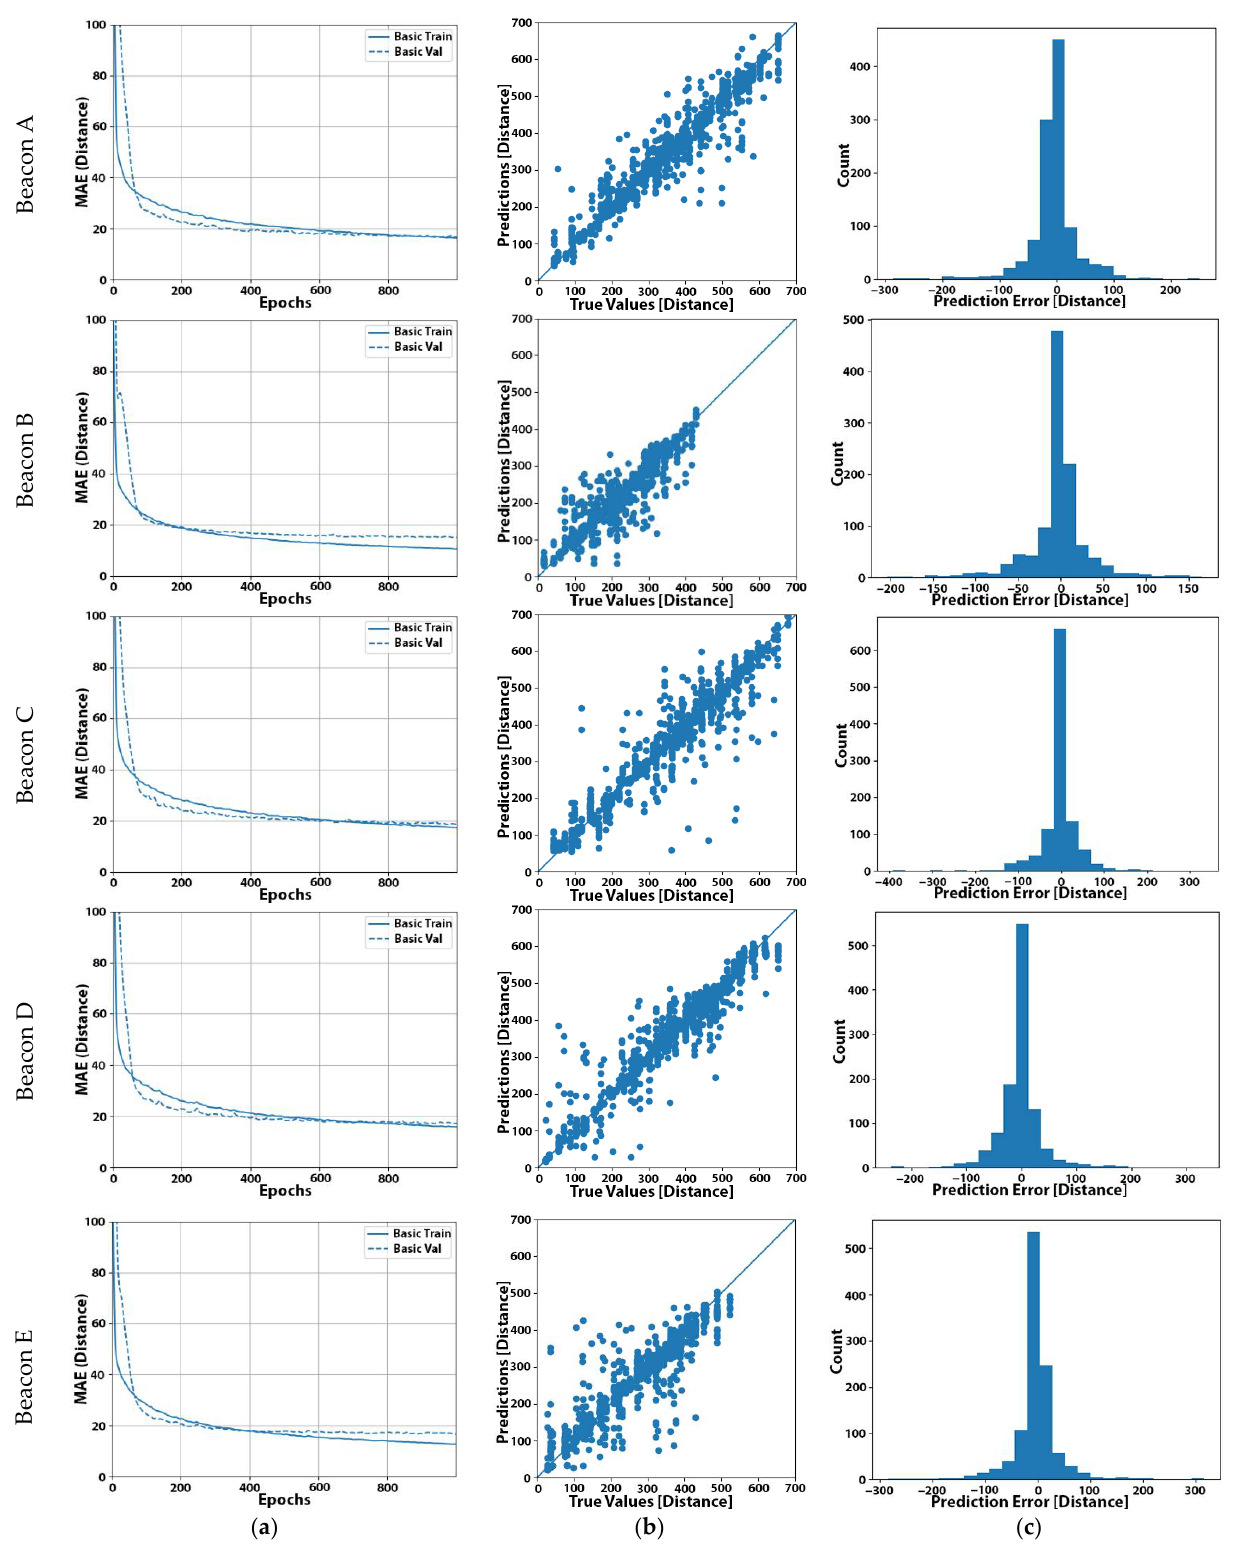
Figure 4. Experiment No. 23 results: ( a ) learning curve with the MAE of our final model; ( b ) plot of the predicted distance (in cm) from our final model against the actual distance of the user for the set of 1111 measurements; ( c ) distribution of the prediction error (in cm) using our final model. (Distances are expressed in cm in ( a – c ).)